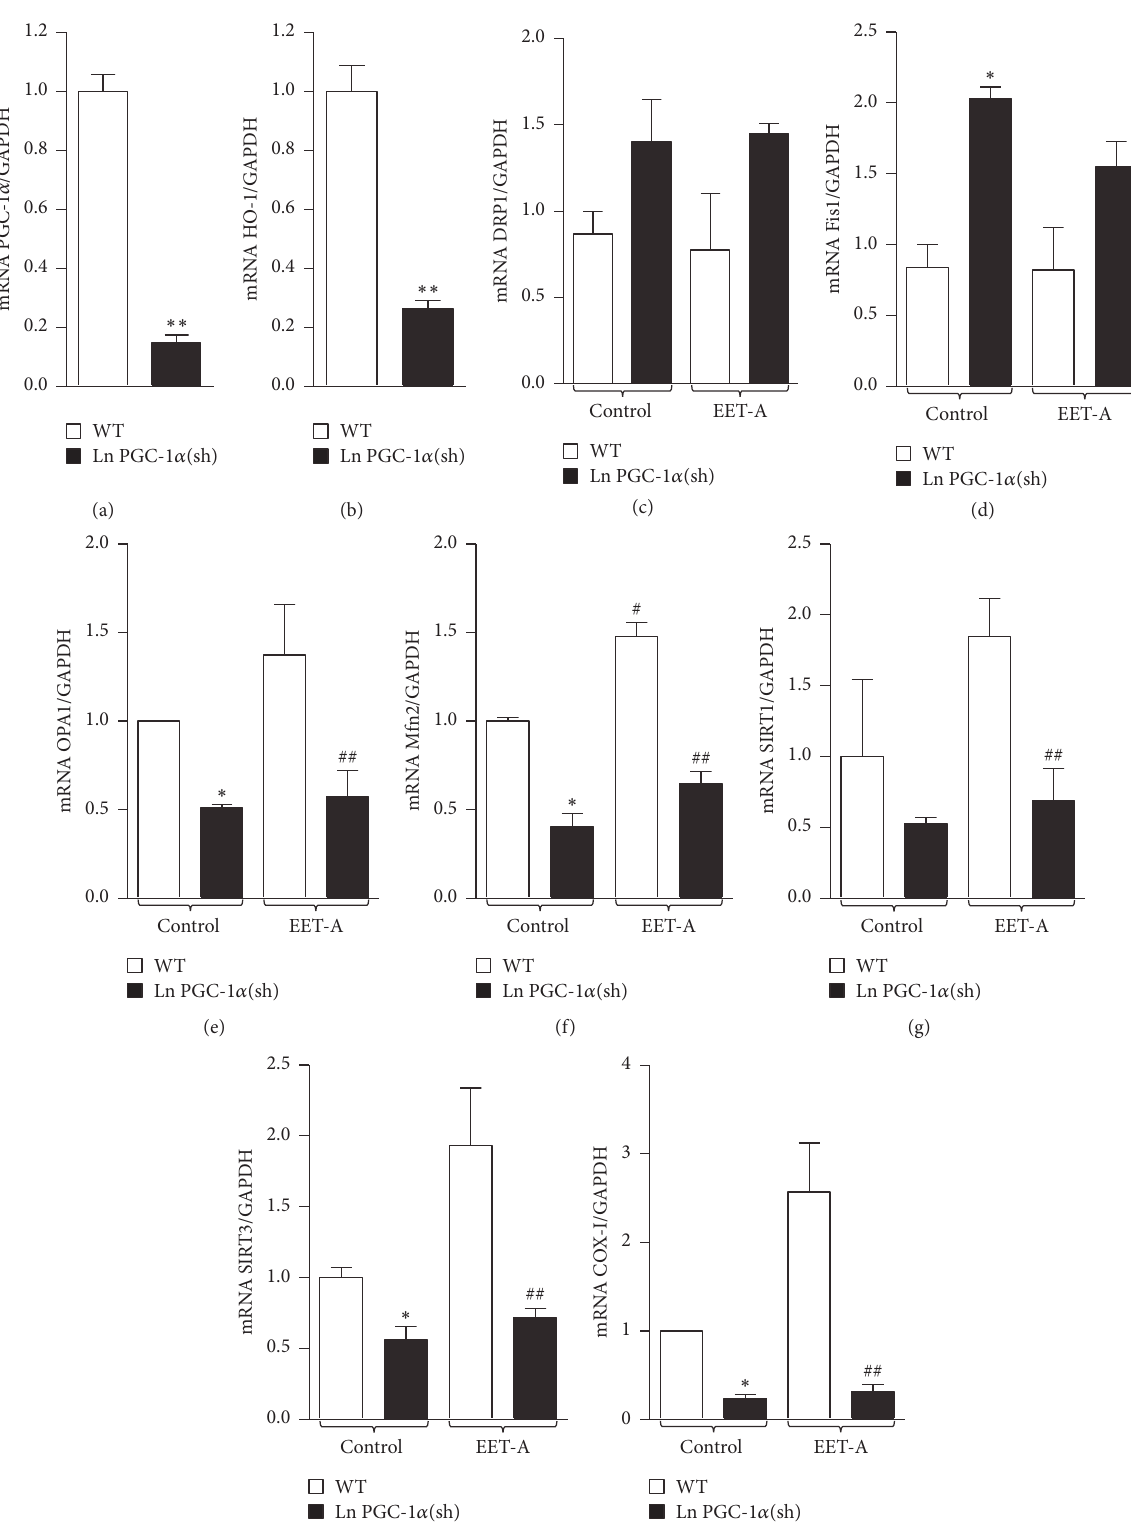
Figure 1: Effect of EET-A treatment on WT and PGC-1 𝛼 -deficient 3T3-L1 adipocytes cells on gene expression related to mitochondrial biogenesis and dynamics. mRNA expression of PGC-1 𝛼 (a), HO-1 (b) in WT and PGC-1 𝛼 deficient 3T3-L1-derived adipocyte cells, and DRP1 (c), Fis1 (d), OPA1 (e), Mfn2 (f), SIRT1 (g), SIRT3 (h), and COX-I (i) in WT and PGC-1 𝛼 deficient 3T3-L1-derived adipocyte cells in the absence and presence of EET-A (10 𝜇 M) treatment. Results are mean ± SE, 𝑛 = 3-4, ∗ 𝑝 < 0.05 versus WT, ∗∗ 𝑝 < 0.01 versus WT, # 𝑝 < 0.05 versus WT, and ## 𝑝 < 0.05 versus WT-EET-A. White bars: WT; black bars: PGC-1 𝛼 deficient